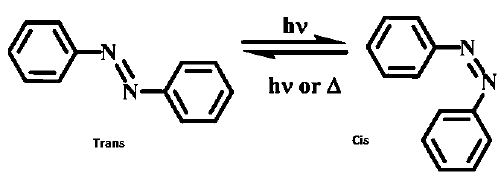
Figure 12. Photoisomerization reaction of PAZO molecule. Adapted from [30].